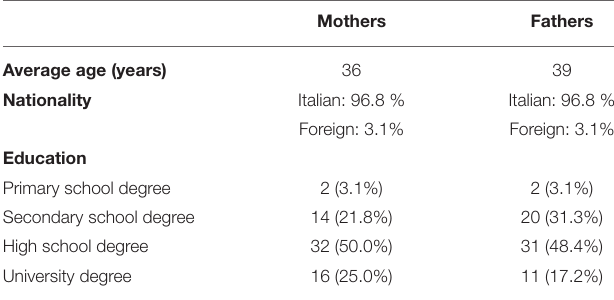
TABLE 5 | Demographics of caregivers regarding the access to the Emergency Department (information from